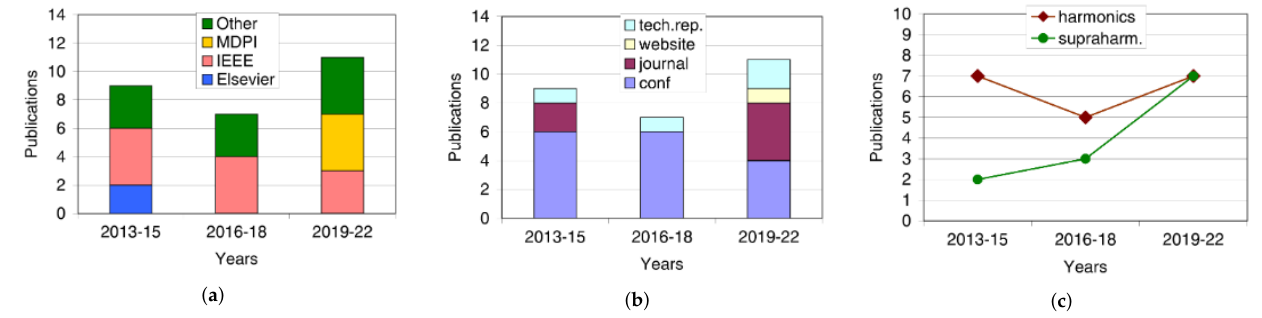
Figure 10. Overview of sources of experimental harmonic and supraharmonic data for electric vehicles: ( a ) publication type versus grouped years, ( b ) publisher versus grouped years, ( c ) topic (harmonics, supraharmonics, counting when both) versus grouped